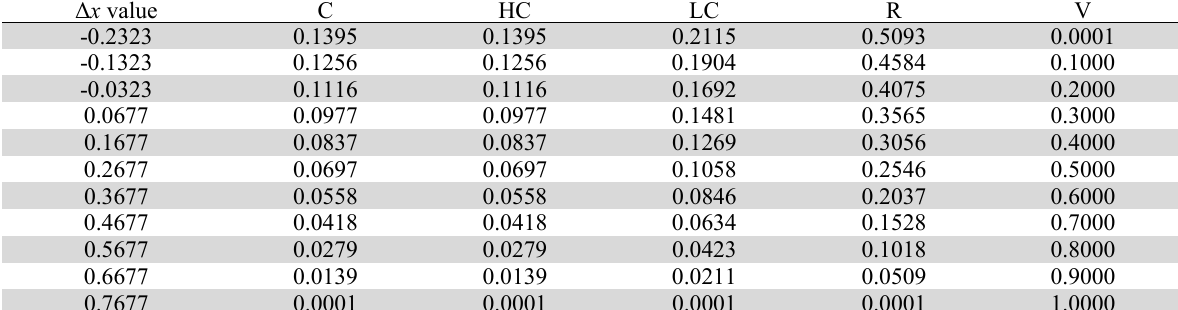
Changing criteria weights for high dimensional weight sensitivity analysis for Example